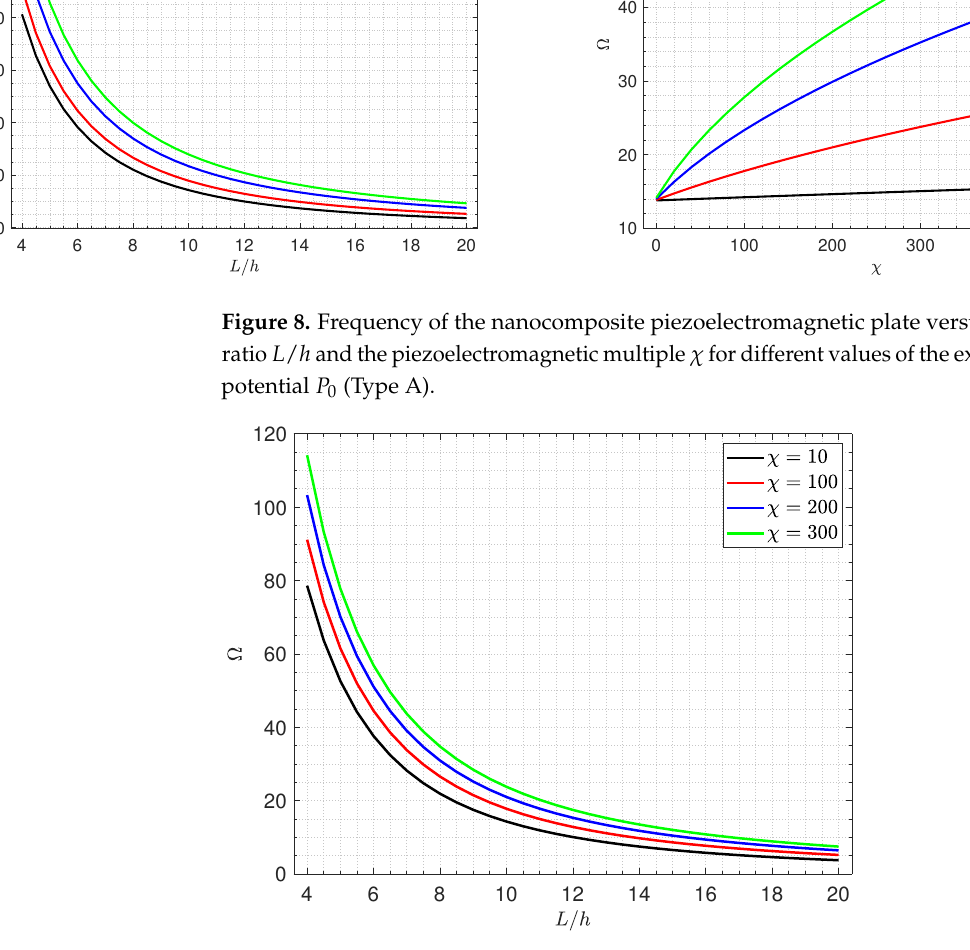
Figure 9. Effects of the piezoelectromagnetic multiple χ on the frequency of the nanocomposite piezoelectromagnetic plate (Type